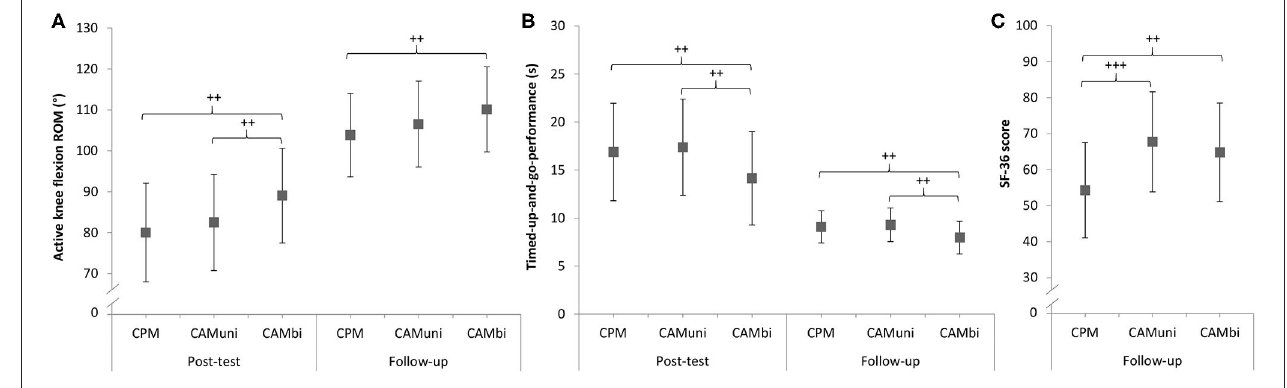
FIGURE 3 | Results of the modified intention-to-treat analyses for (A) the primary outcome active knee flexion range of motion (ROM), (B) timed-up-up-and-go-performance and (C) quality of life (SF-36 score) at post- and follow-up tests, respectively. CPM, continuous passive motion; CAMuni, continuous active motion unilateral; CAMbi, continuous active motion bilateral; + Denotes the clinical relevance (Cohen’s d effect size) for post-hoc comparisons between groups: ++ medium effect (Cohen’s d 0.50–0.79), + + + large effect (Cohen’s d ≥